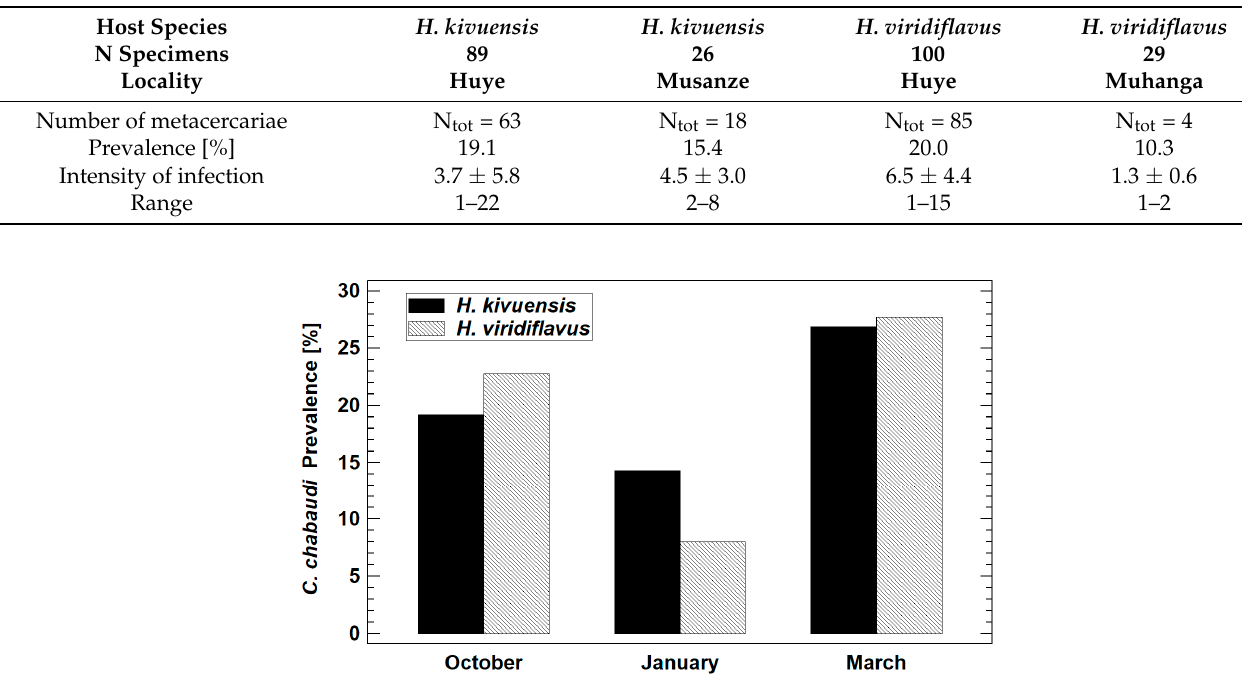
Table 4. Clinostomum chabaudi metacercariae infesting lymphatic sacs, mouth, and body cavity of Hyperolius reed frogs in Rwanda: number of metacercariae (N tot ), prevalence (presented as the number of parasitized frog hosts by the total number examined), mean intensity of infection ± SD (as mean number of parasites per individual frog), and range of metacercariae recorded.